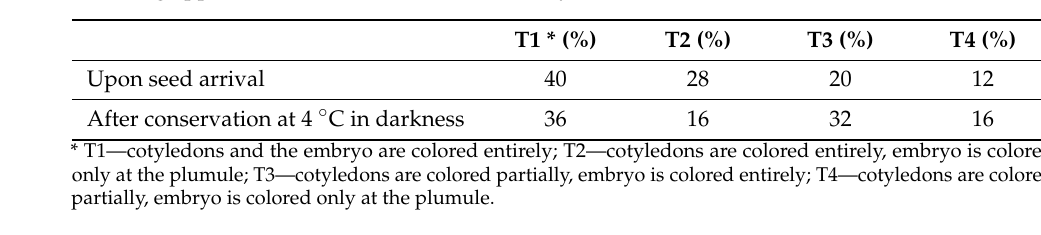
Table 2. Seed viability and germination rates of entire seeds and excised embryos of Arachis hypogaea L.